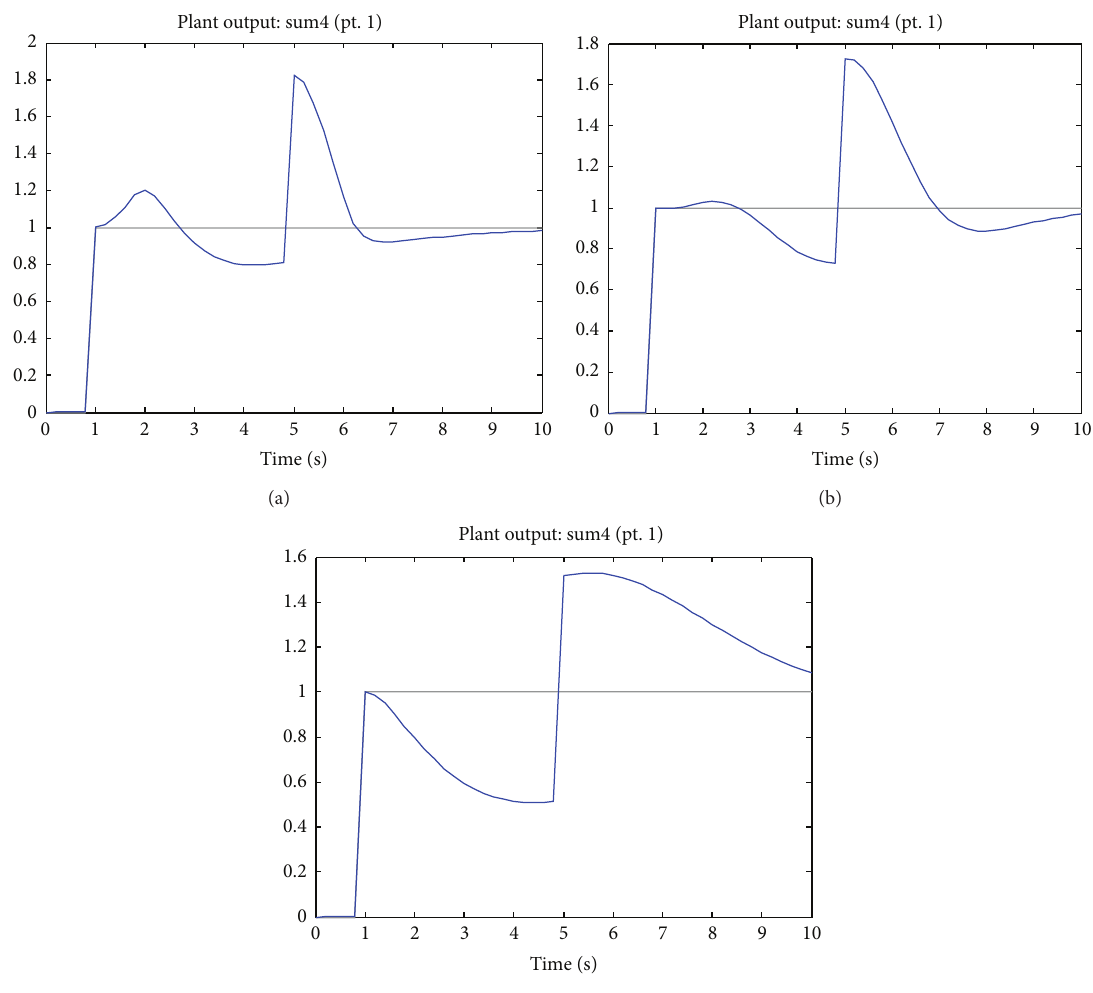
Figure 12: MPC controller performance is shown for three cases where the ratio of speed of response versus robustness of the MPC controller is adjusted to 1.0 (a), 0.5 (b), and 0.3 (c). Plant output is shown in blue versus the reference setpoint in